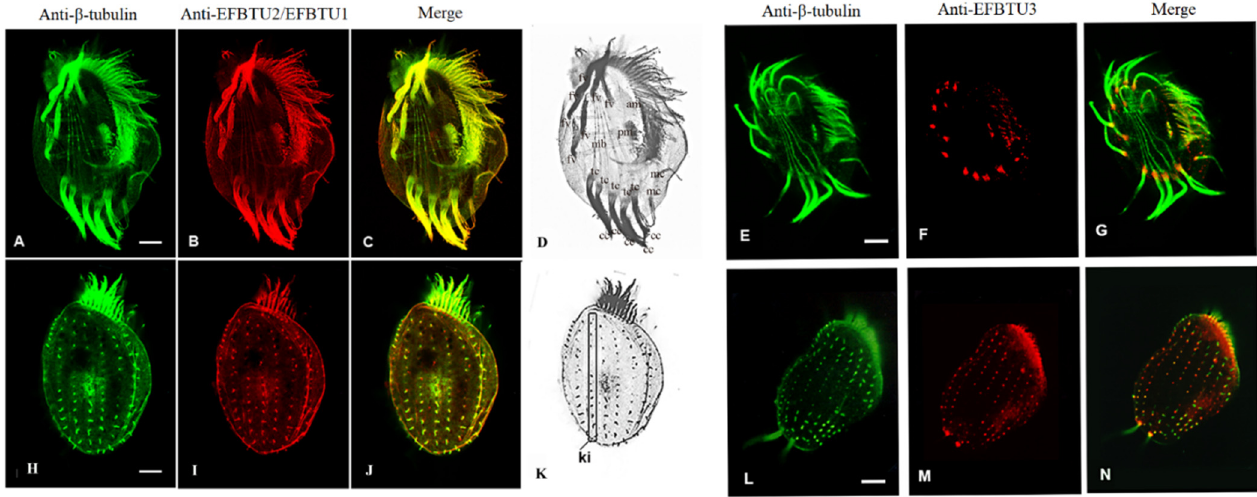
Figure 1. Cellular localization of EFBTU2/EFBTU1 and EFTBTU3 tubulin isotypes in E. focardii cells. ( A – C , E – G ) represent confocal immunofluorescence microscopic images of the ventral surface of E. focardii cells, whereas ( H – J , L – N ) are images of the dorsal surface of cells co-stained with anti- β -tubulin (green) and either anti-EFBTU2/EFBT1 or anti-EFBTU3 (red) antibodies, respectively. Cytoskeletal structures of the ventral and dorsal surfaces are highlighted in ( D , K ), which represents the black and white version of the merged images ( C , J ), respectively: adoral membranelles (am), transverse cirri (tc), caudal cirri (cc), marginal cirri (mc) and the microtubule bundles (mb), which elongate from the basal bodies of each transverse cirrus (tc) into the cytoplasm, frontoventral cirri (fv) and kineties (ki). The images in the left panel show that the staining of the isotypes EFBTU2/EFBTU1 largely overlaps with that of the β -tubulin antibodies, which recognize virtually all the microtubular structures of the cell, whereas the right panel shows that the isotype EFBTU3 mainly accumulates in microtubules at the base of the cilium. Scale bars correspond to 10 µ